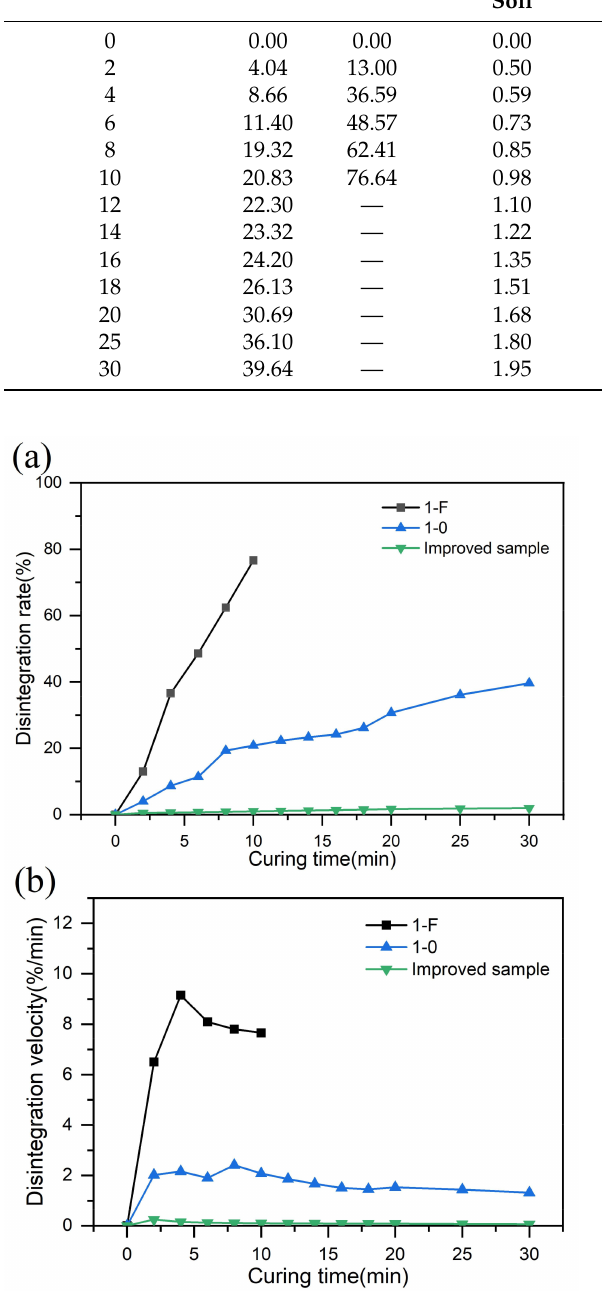
Figure 11. Disintegration characteristic development curve: ( a ) disintegration rate; ( b ) disintegration